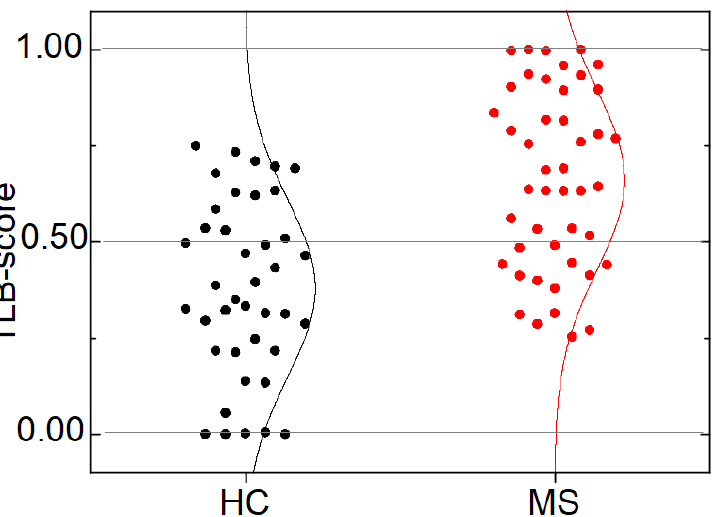
Figure 5. Distribution of the TLB score within healthy individuals (HC group) and multiple sclerosis patients (MS group). The lines represent an equivalent Gaussian distribution. The TLB score threshold for discriminating between an unaltered and altered thermal liquid biopsy (TLB) thermogram is 0.5. There are 13 HC subjects with TLB score > 0.5 (32.50% false positive rate) and 14 MS patients with TLB score < 0.5 (31.11% false negative rate).